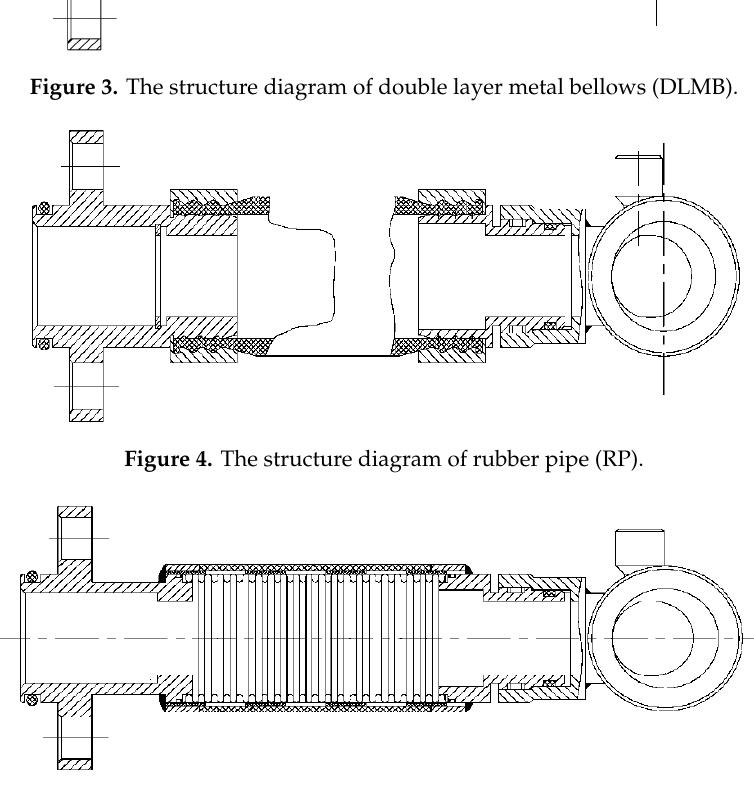
Figure 5. The structure diagram of and bellows coated rubber (BCR). Table 1. Material parameters.